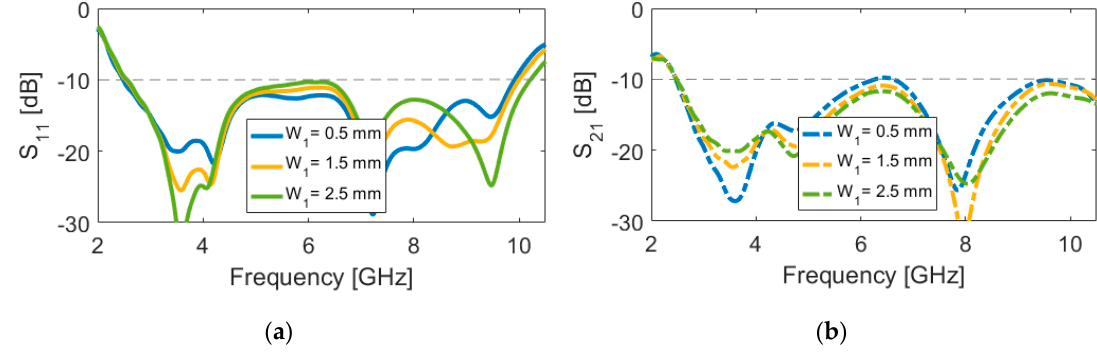
Figure 8. ( a ) S 11 and ( b ) S 21 characteristics for di ff erent values of W 1 .